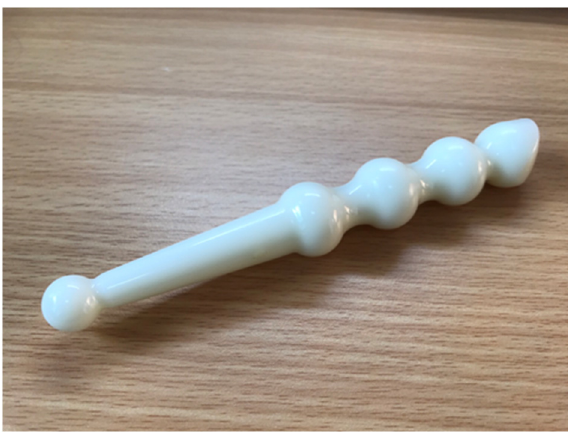
Figure 4. FJM rods used in plantar reflexology .